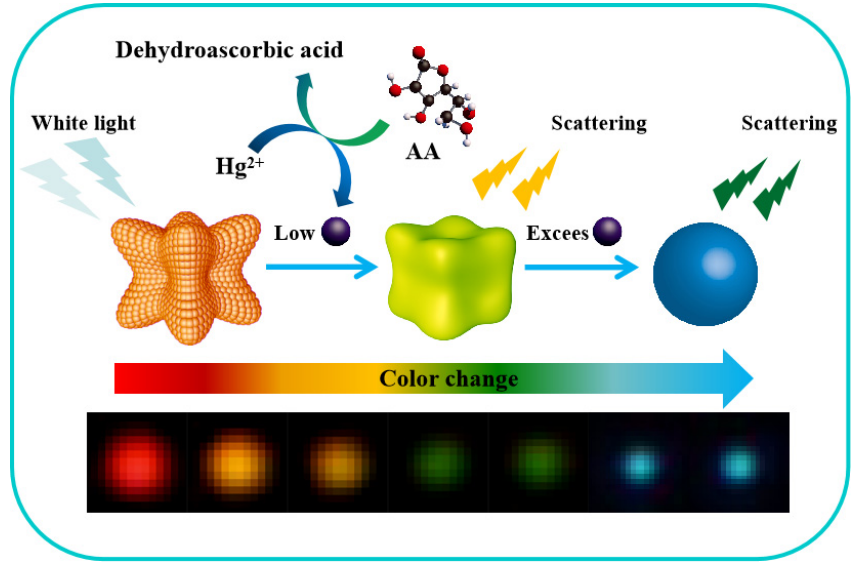
Scheme 1. Schematic illustration of the Hg 2+ detection method based on single particle color imaging under DFM.